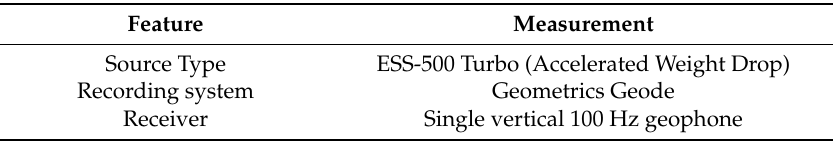
Figure 2. Field acquisition scheme of seismic reflection profile 2. ( a ) Stacking chart (blue crosses—receivers, red squares—shots); ( b ) Fold distribution. The total number of shots was 59, with 48 active channels per cable which gave a nominal fold of 15. Table 1. Seismic acquisition parameters.